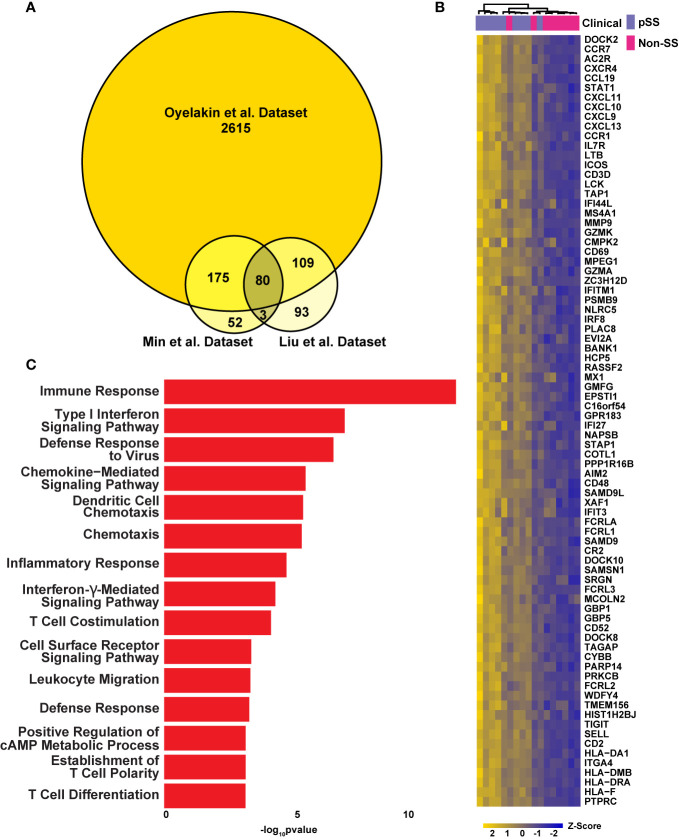
Integrated Analysis Reveals a pSS Molecular Signature. (A) Venn diagram displaying the overlay of up-regulated genes identified in the RNA-seq dataset described here (Oyelakin et al.) and Min et al. (50) and Liu et al. (49) datasets. (B) Heatmap visualization of the 80 common upregulated genes identified in panel A. (C) Bar plot highlights biological processes enriched in the 80 common upregulated genes identified in panel A above.